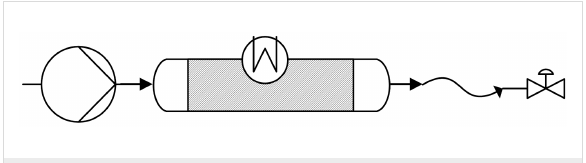
Figure 16: Reactor set-up (left to right): UHPLC pump, heated fixed- bed reactor, capillaries (ID: 25 µm or 50 µm, length: 30 cm), back pres- sure regulator (up to 30